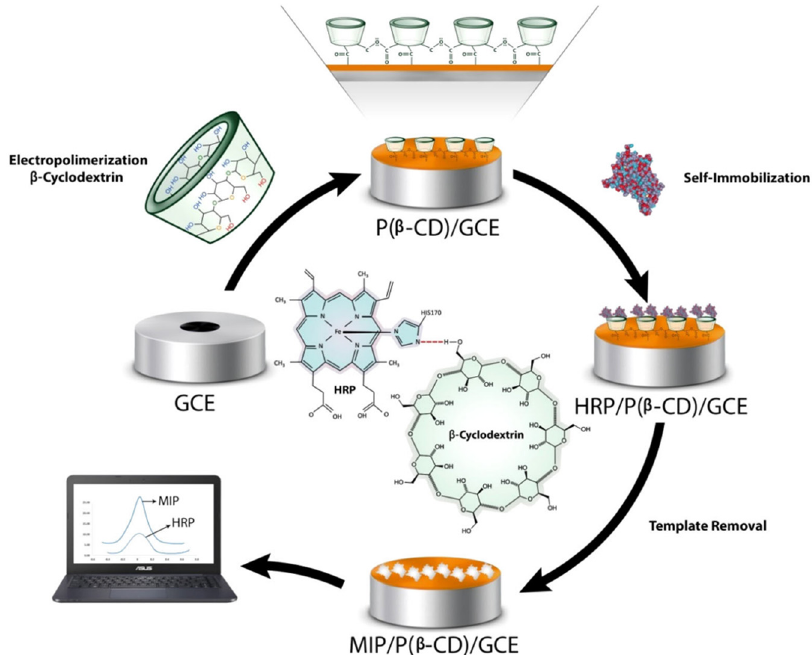
Figure 14. MIP/P( β -CD)/GCE preparation and detection of HRP. Reproduced from the work in [136] with permission from Wiley.